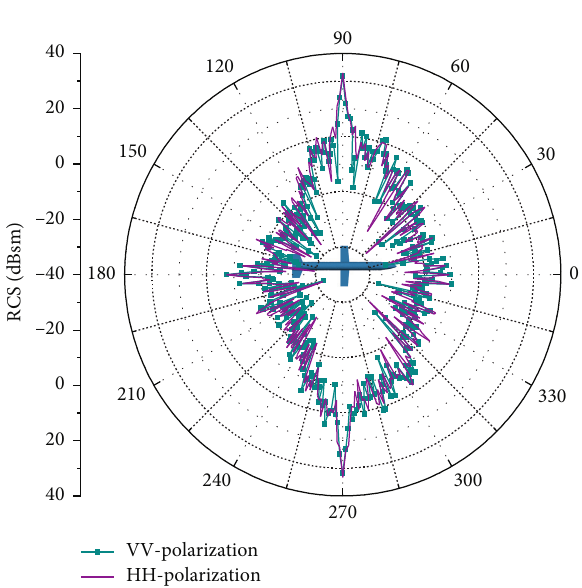
Figure 4: Monostatic RCS of a missile at 10GHz.